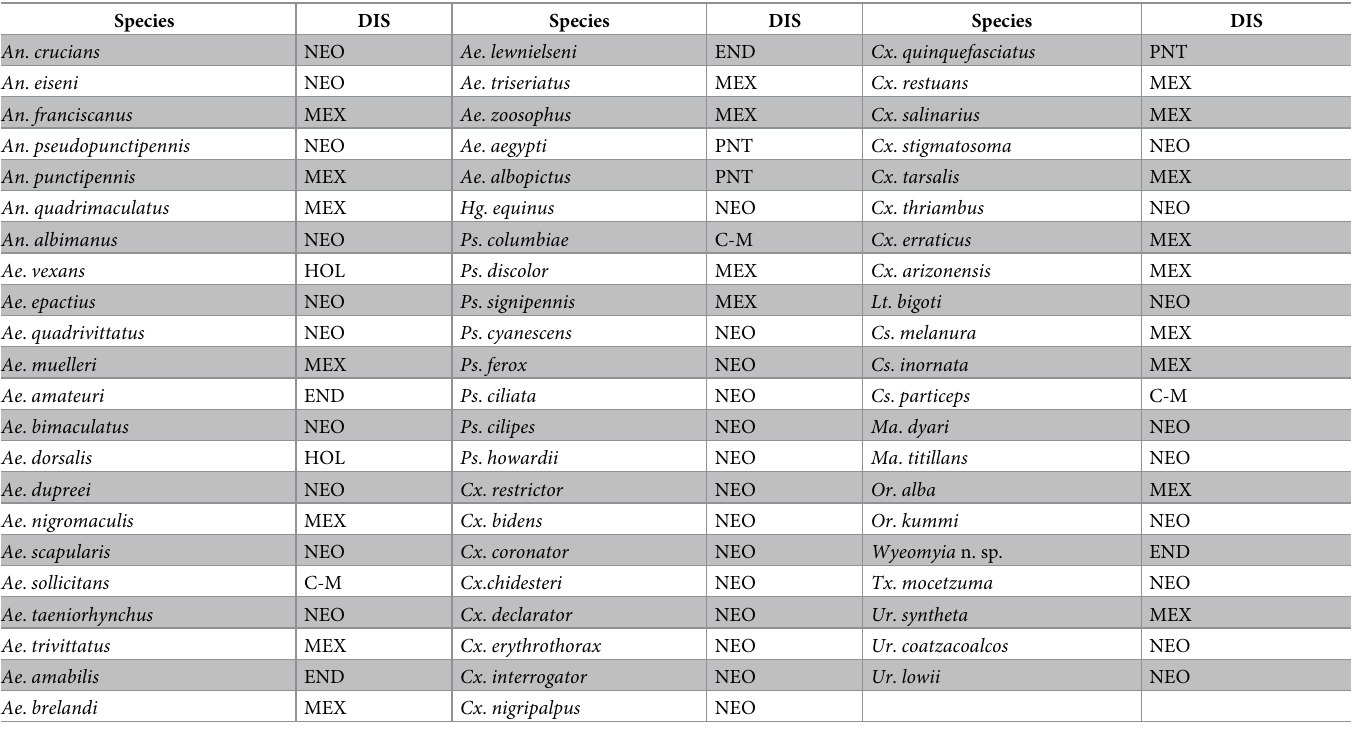
Table 3. Distribution of the mosquito fauna of Nuevo Leo´n